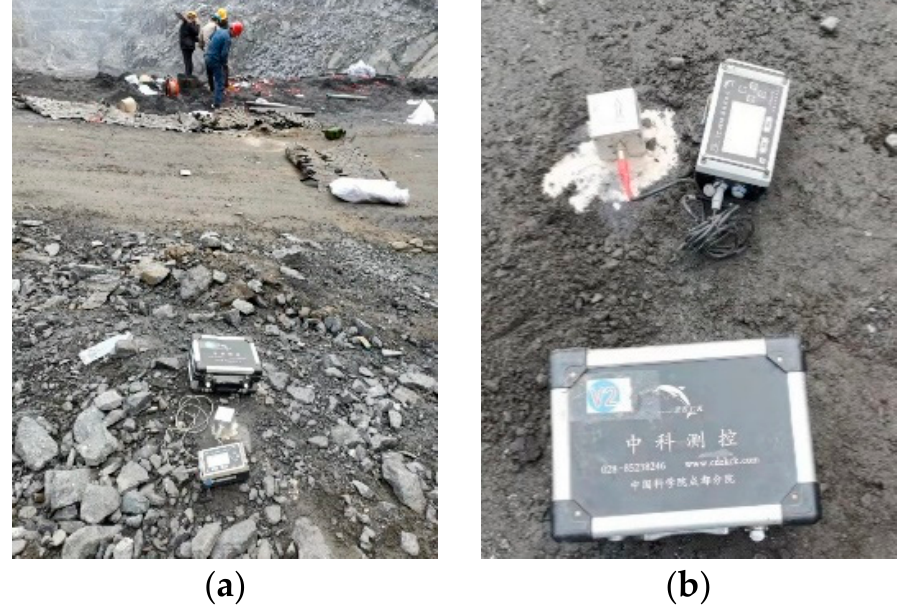
Figure 5. Vibration velocity monitoring equipment. ( a ) Relative position of velocity sensor and rock breaking area; ( b ) Installation diagram of speed sensor.